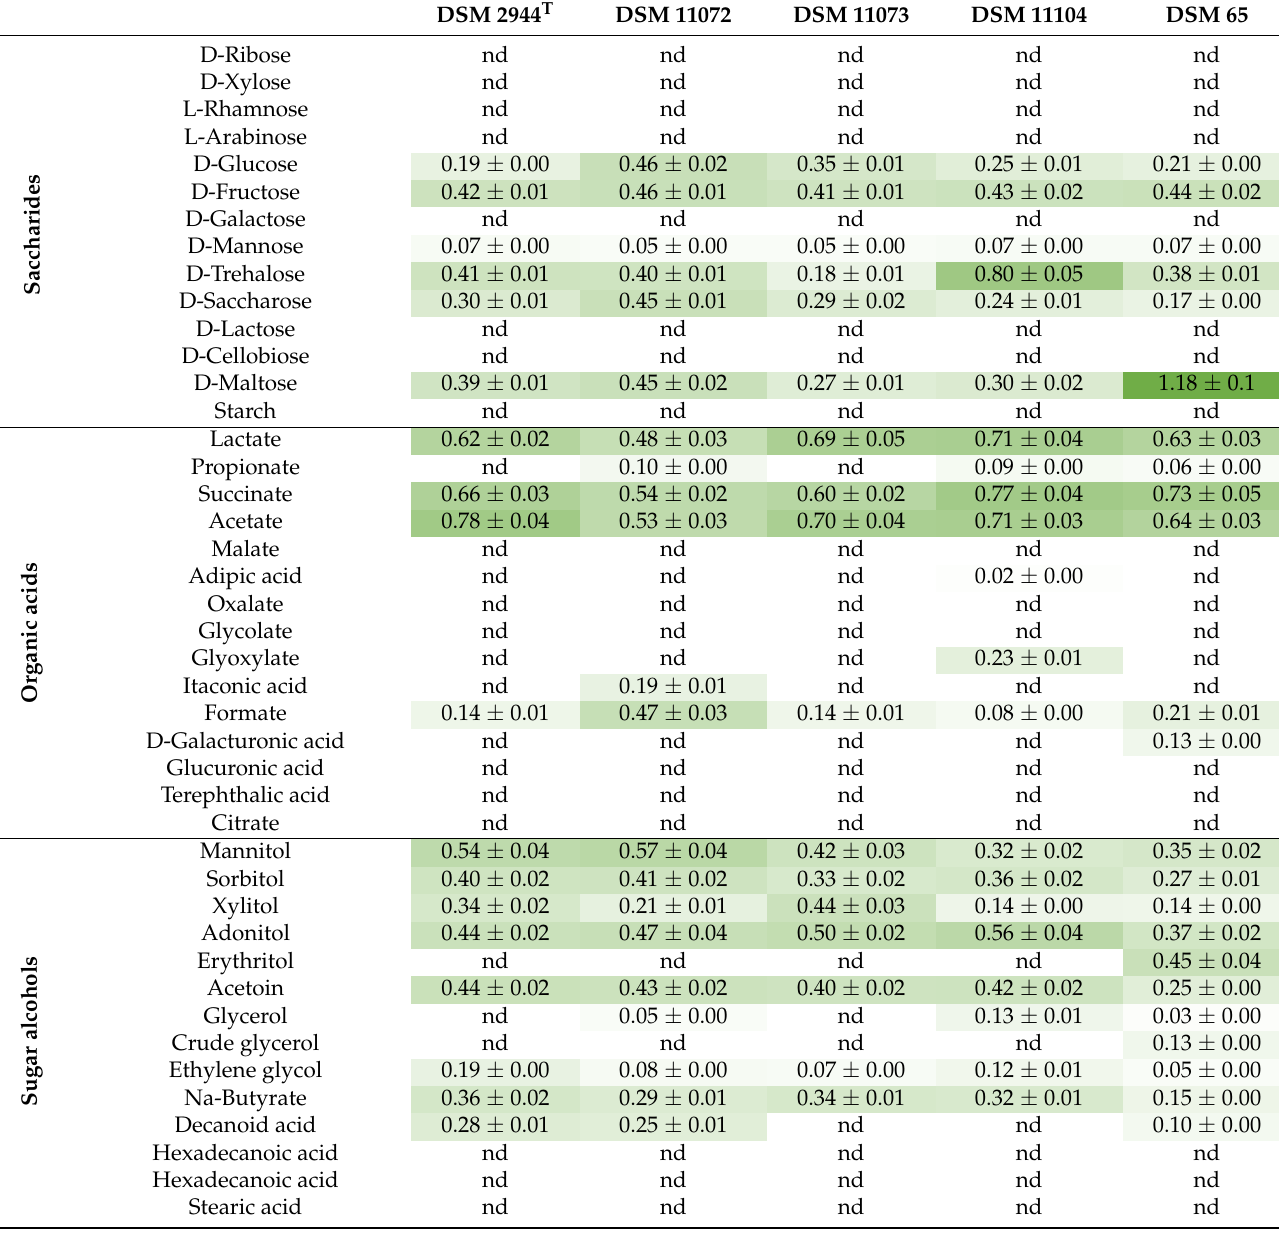
Table 1. Overview of maximum growth rates (h − 1 ) for the five investigated strains with different substances as sole carbon sources. All of the experiments were performed in triplicates in 96-well plates with an MSM medium in a Growth Profiler. Online green value data were recorded and values were transformed into OD values to automatically calculate growth rates via an in-house MATLAB script. nd = no exponential growth